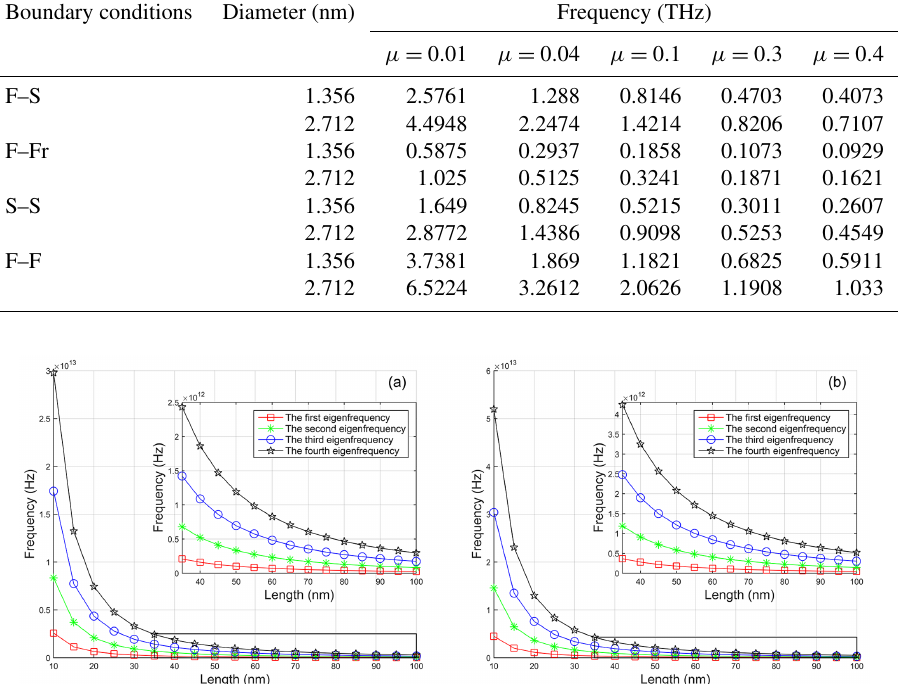
Figure 5. The first four eigenfrequencies of fixed–simply supported armchair nanotubes with nonlocal parameter µ = 0 . 01, (a) nanotube with chirality ( n , m ) = (10, 10) and diameter D = 1 . 356nm, (b) nanotube with and chirality ( n , m ) = (20, 20), diameter D = 2 .